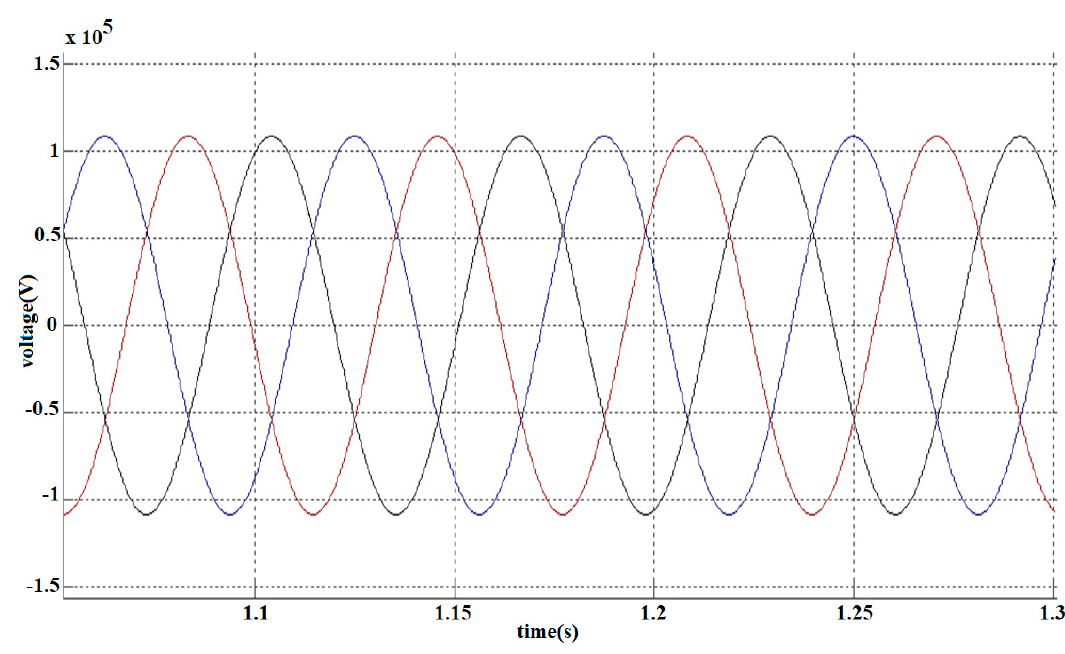
Figure 35. Voltage waveforms at the node.